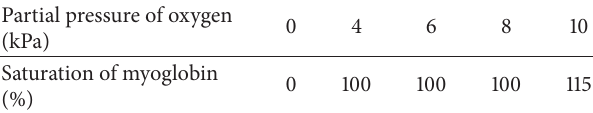
Table 3: Numerical results corresponding to Figure 2.